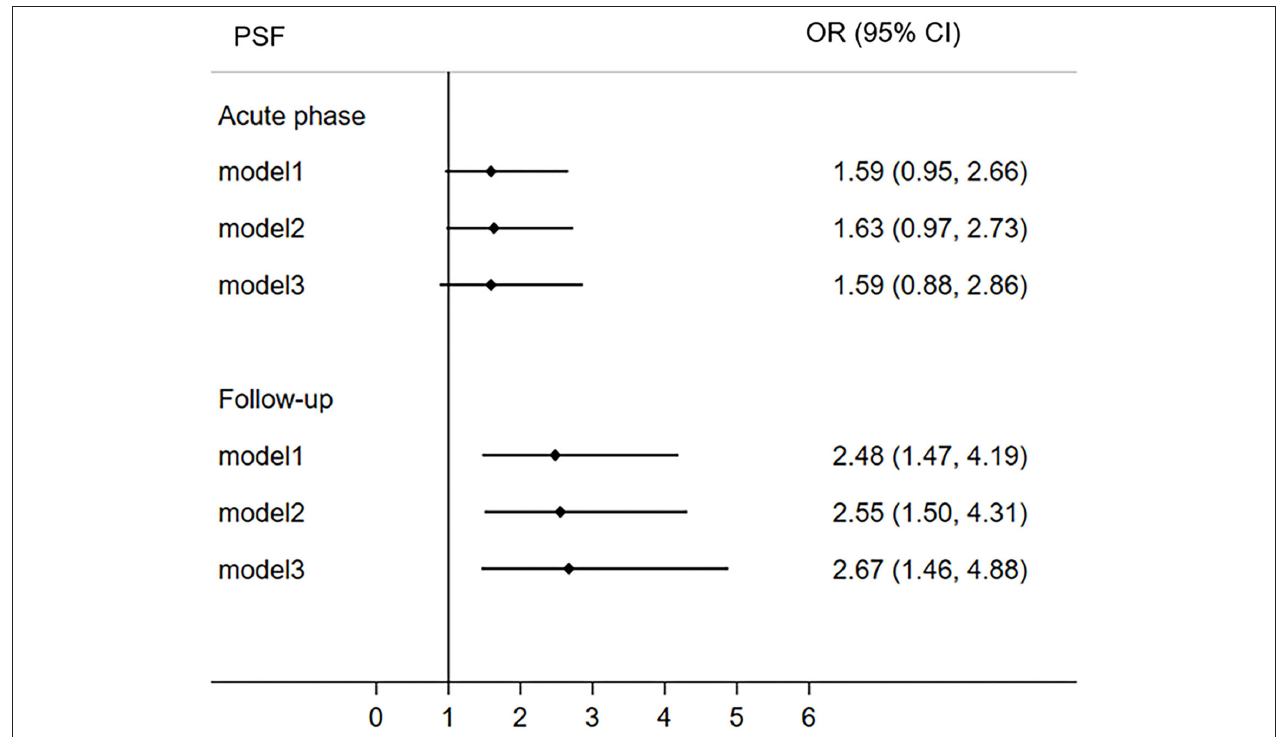
FIGURE 6 | The correlation between right thalamus and post-stroke fatigue both in the acute phase and 6-month follow-up. The right thalamus comes from the result of VLSM analysis of poststroke fatigue at 6-month follow-up. CI, confidence interval; OR, odds ratio; PSF, post-stroke fatigue; VLSM, voxel-based lesion-symptom